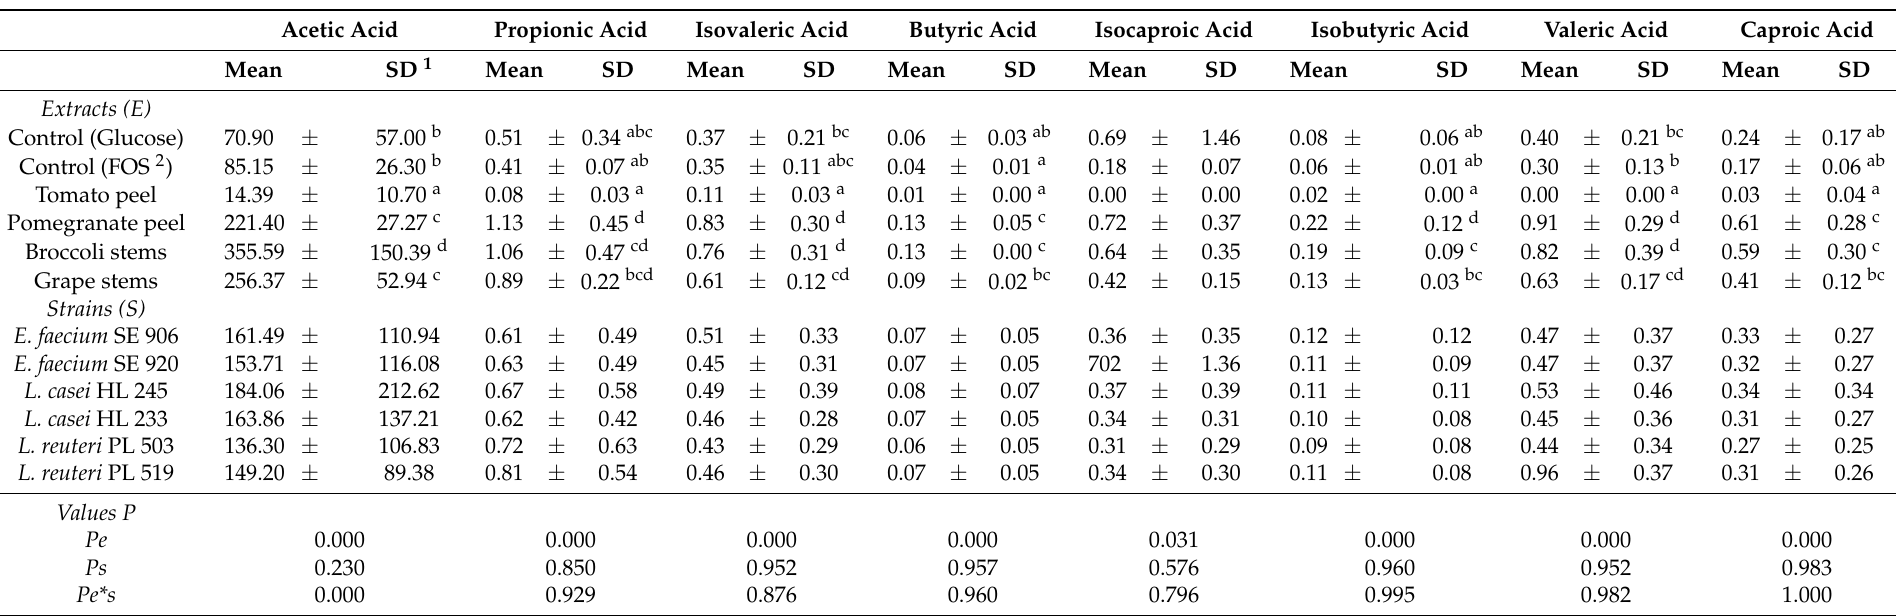
Table 4. Production of short-chain fatty acids in mM of lactic acid bacteria (LAB) in the presence of different soluble fibre extracts. Acetic Acid Propionic Acid Isovaleric Acid Butyric Acid Isocaproic Acid Isobutyric Acid Valeric Acid Caproic